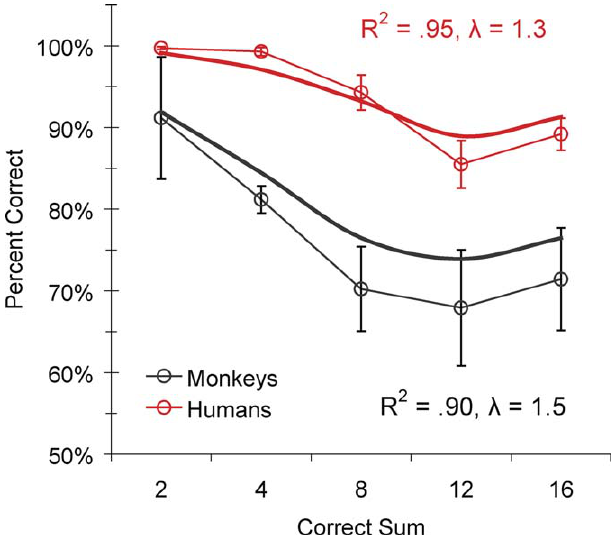
Figure 6. The Effect of the Magnitude of the Sum on Accuracy for Addition Trials Monkeys and humans performed less accurately as the numerical magnitude of the sum of the sample sets increased. Bolded lines show the predicted data from Figure 5 presented as a function of sum size. Error bars reflect the standard error among